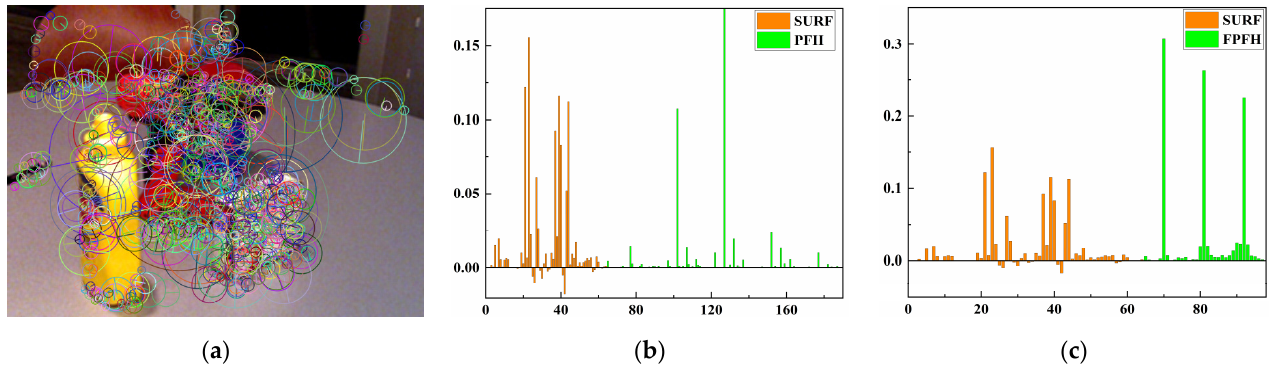
Figure 9. Extracted SIFT feature points and feature histograms of SIFTPFH and SIFTFPFH at pixel ( 374, 373 ) . ( a ) Extracted SIFT feature points; ( b ) SIFTPFH feature histogram; ( c ) SIFTFPFH feature histogram.